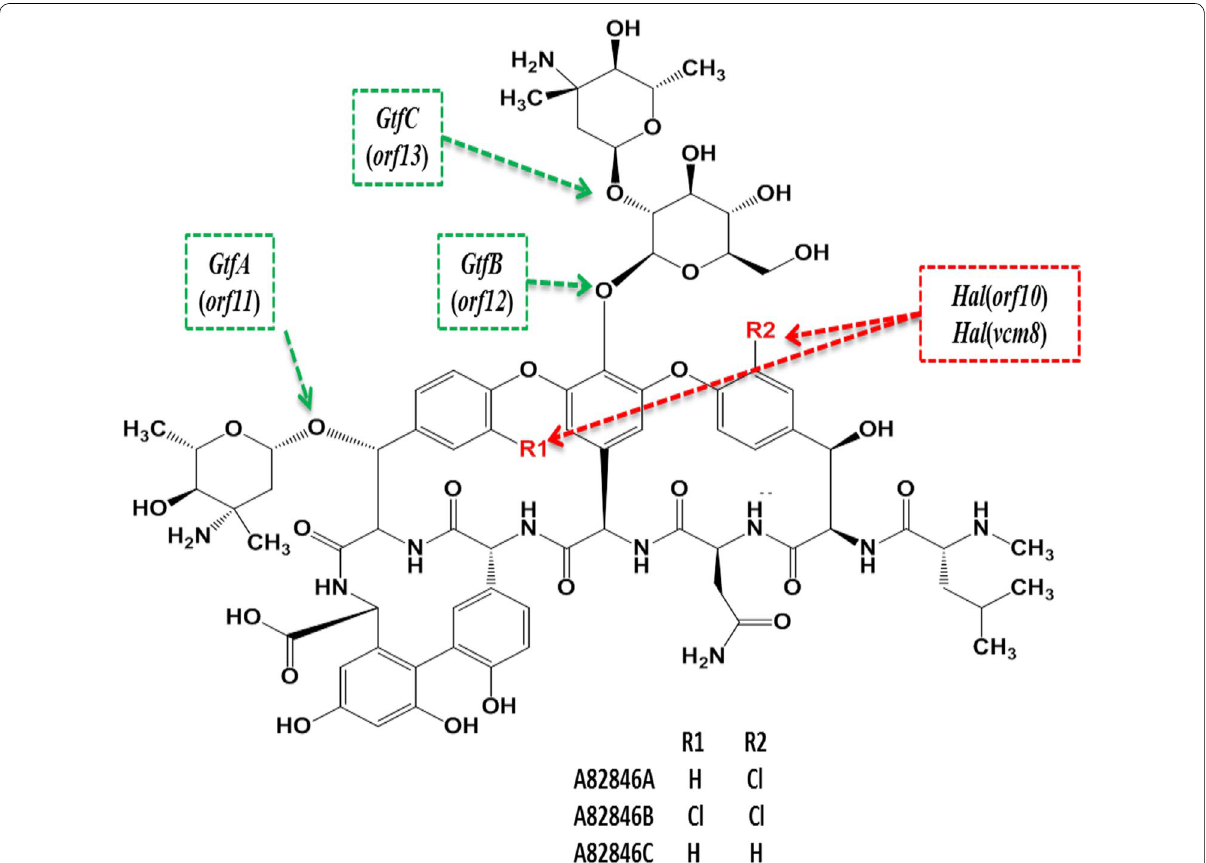
Fig. 1 Structure and the key biosynthesis gene of A82846. Green box is a glycosyltransferase reaction site; red box is a halogenase reaction site; encoded gene of enzyme in